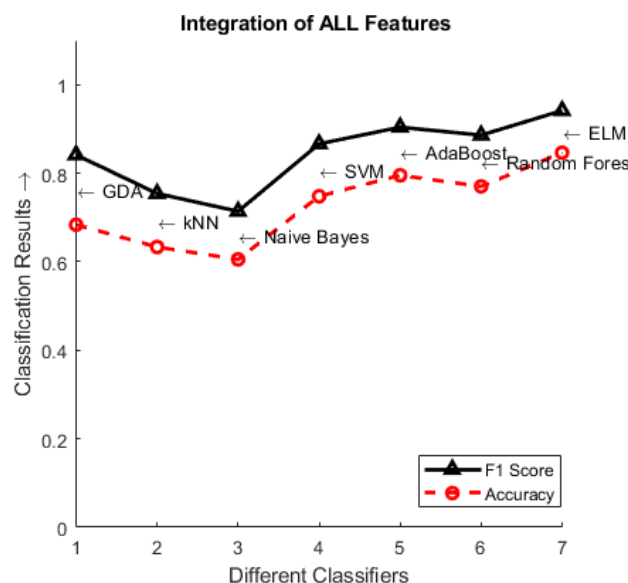
Figure 6. Classification results using the integration of all features (i.e., FI 3) among the classifiers. Table 3. AUC comparison of the 14 pathologies classification in the ChestX-ray14 literature.